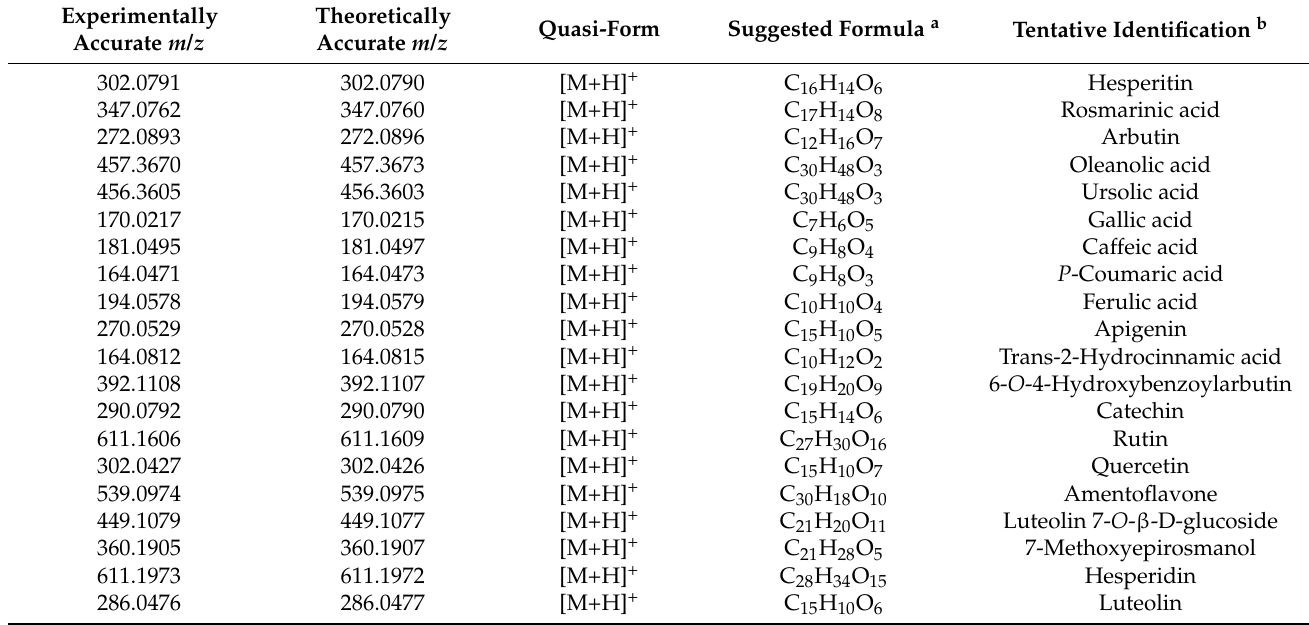
Table 1. LC-HRESIMS analysis of OM extract.